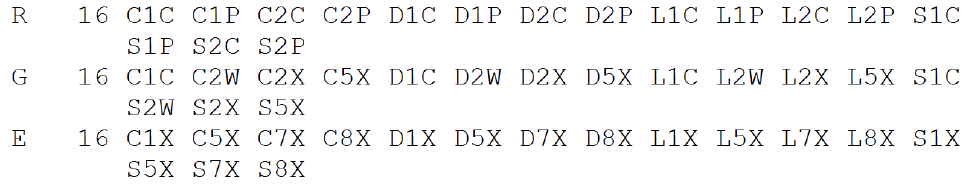
(CORRs) between sea-level retrievals and sea-level measurements, and the number of retrieval points are summarized in Table